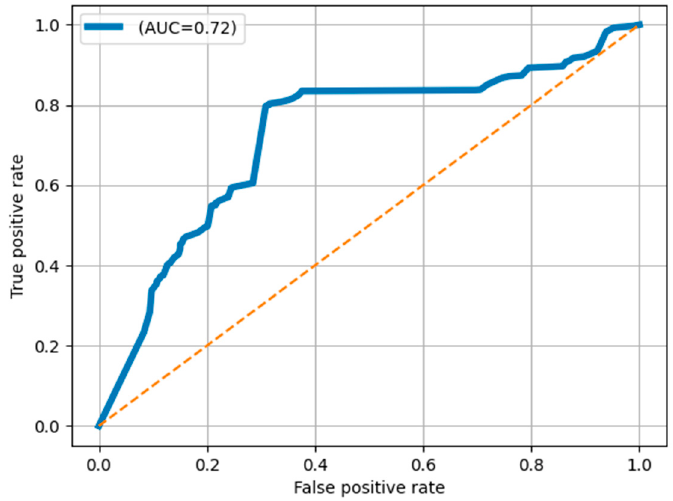
Figure 8. ROC curve and AUC value achieved for new variant prediction using the proposed tech- nique.